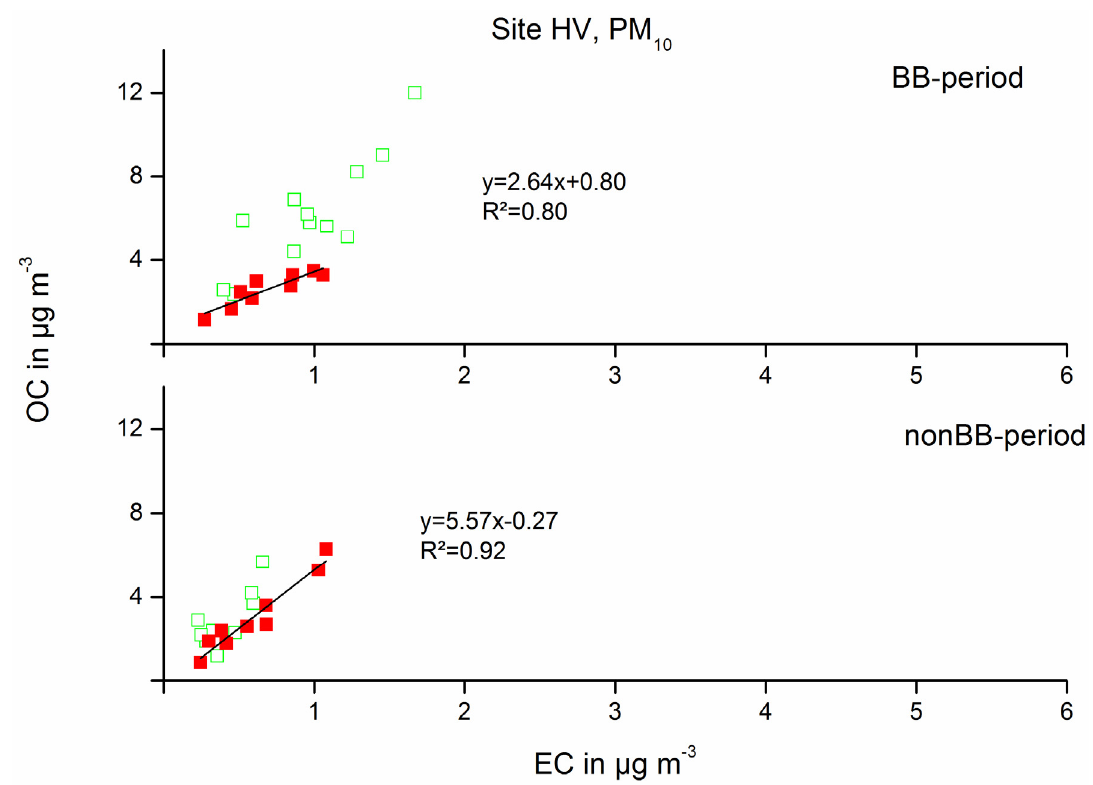
at site HV, PM p